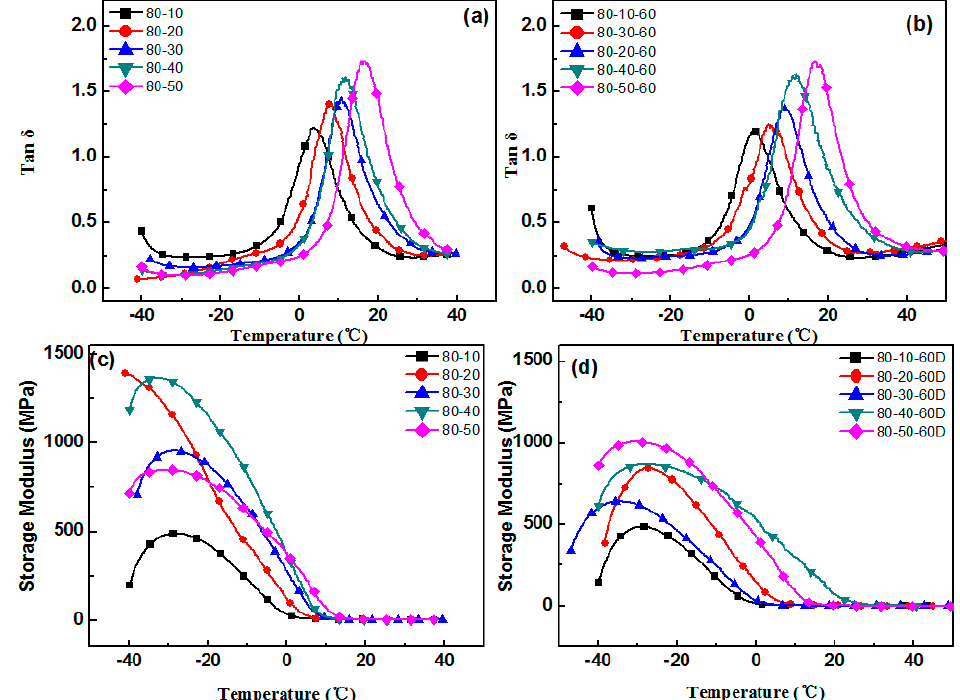
Figure 2. The effect of thermal aging on the storage modulus and tan δ of the XNBR/AO-80 blends: ( a ) tan δ of XNBR/AO-80; ( b ) tan δ of XNBR/AO-80 after aging; ( c ) the storage modulus of XNBR/AO-80; ( d ) the storage modulus of XNBR/AO-80 after aging.